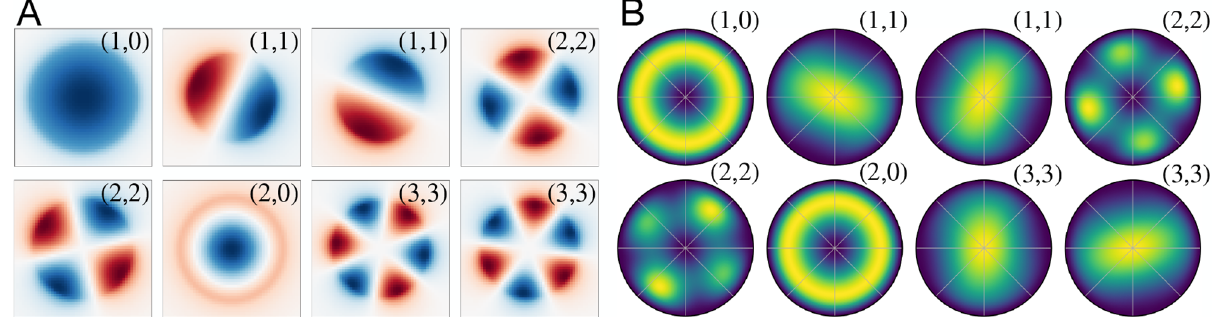
Fig. 2. QNMs of the circularly faceted spherical NPoM geometry, ordered in increasing energy: (1,0), (1,1), (1,1), (2,2), (2,2), (2,0), (3,3), (3,3). A. Normalised QNM electric fi elds E z,lm in the xy -plane through the centre of the cavity. B. Time averaged far- fi eld Poynting fl ux 〈 S lm i .